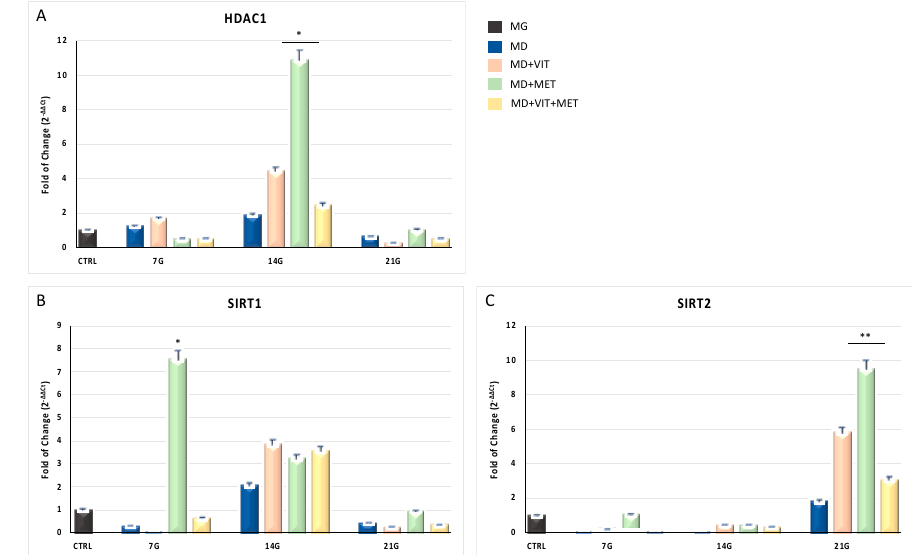
Figure 3. Expression of epigenetic modulating genes. The expression of HDAC1 (Panel ( A )), SIRT1 (Panel ( B )), and SIRT2 (Panel ( C )) was evaluated in ADSCs cultured in: growing medium (MG), adipogenic differentiation medium (MD) (blue bars), or in MD in the presence of vitamin D (orange bars), or in MD in the presence of metformin (green bars), or in MD with metformin plus vitamin D (yellow bars). The mRNA levels for each gene were normalized to glyceraldehyde-3-phosphate-dehydrogenase (GAPDH) and expressed as fold of change (2 −∆∆ Ct ) of the mRNA levels observed in undifferentiated control ADSCs (black bar) defined as 1 (mean ±SD; n = 6). Data are expressed as mean ± SD referred to the control (* p ≤ 0.05; ** p ≤ 0.01).